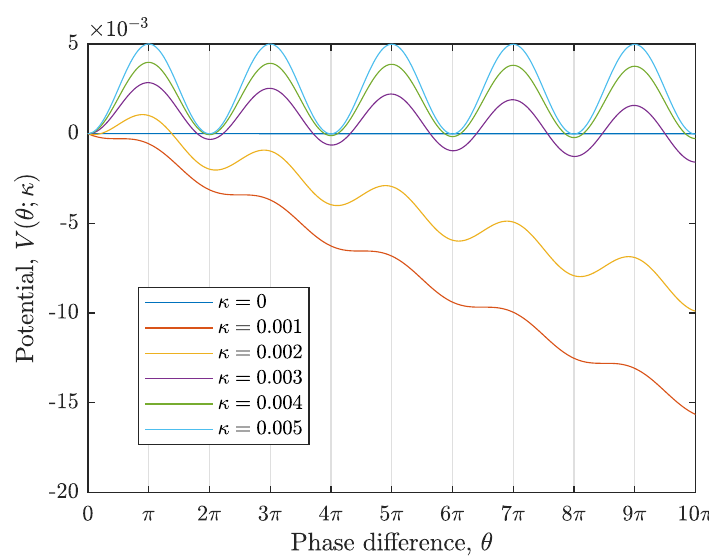
Figure 8. Potentials V ( θ ; κ ) for different values of coupling strength κ